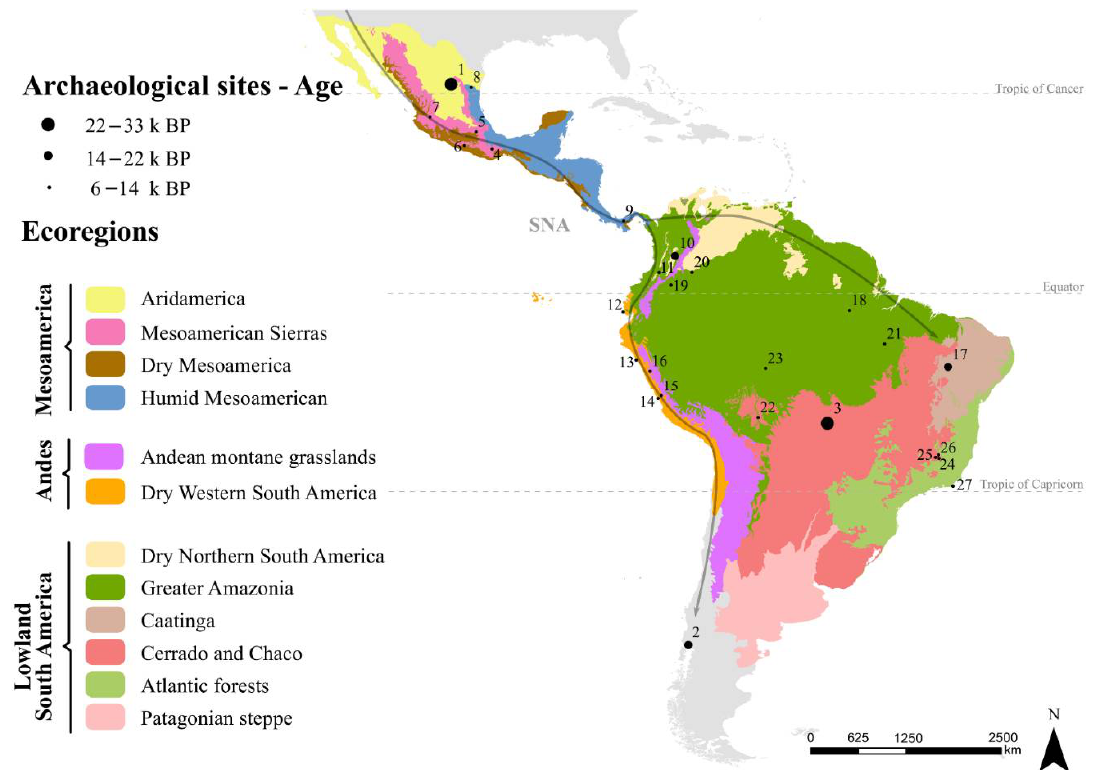
Figure 2. Map of the Neotropical region with major ecoregions and archaeological sites mentioned in the text. The black circles show the location of the archaeological sites; the size of the circles represents three age ranges (for correspondence of numbers and names of sites see Appendix B). Ecoregions are a combination of CONABIO [116] and Olson et al. [117] for Mesoamerica, and Romano [118] and Antonelli et al. [119] for South America. Hypothetical Southern Native American (SNA) migration routes (gray arrows) follow Waters [108].